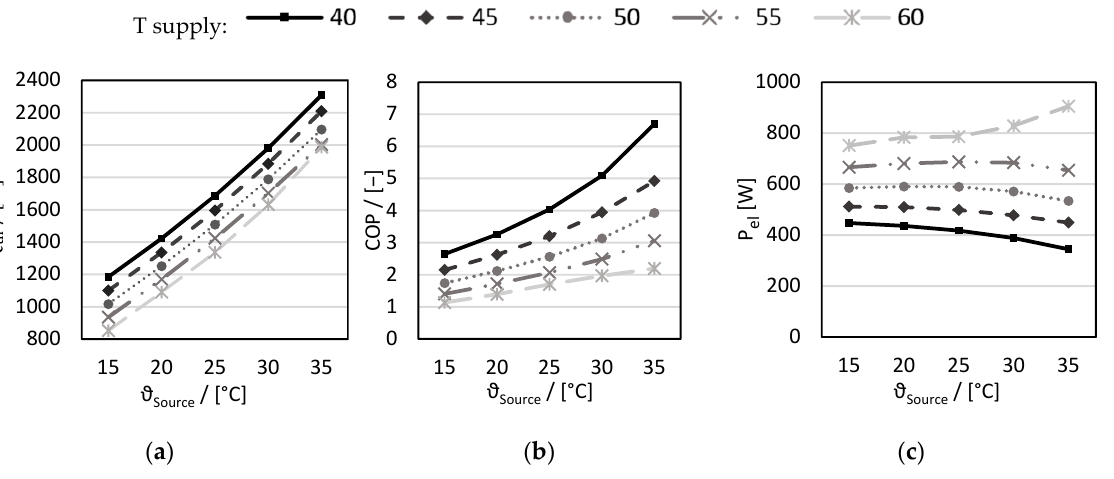
Figure 10. Performance maps of the booster HP (i.e., ( a ) thermal energy; ( b ) COP and ( c ) electric power).